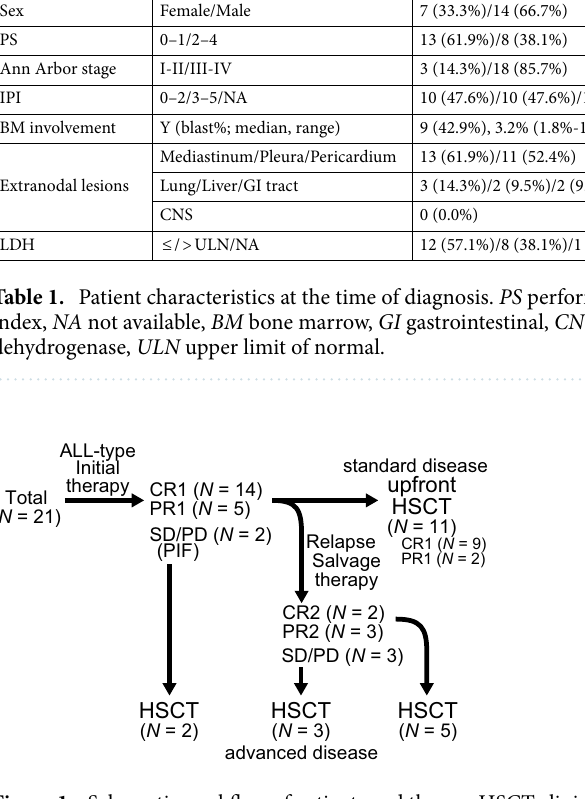
Figure 1. Schematic workflow of patients and the pre-HSCT clinical course. Summary of treatment response from diagnosis to HSCT. Upfront HSCT at CR1/PR1 was categorized as standard disease, while HSCT performed in the other status was classified as advanced